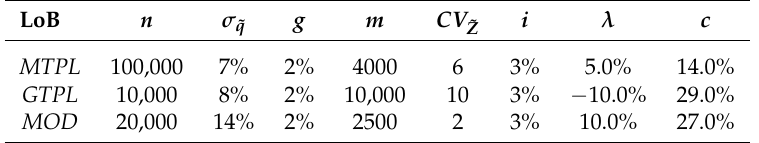
Table 2. Parameters for premium